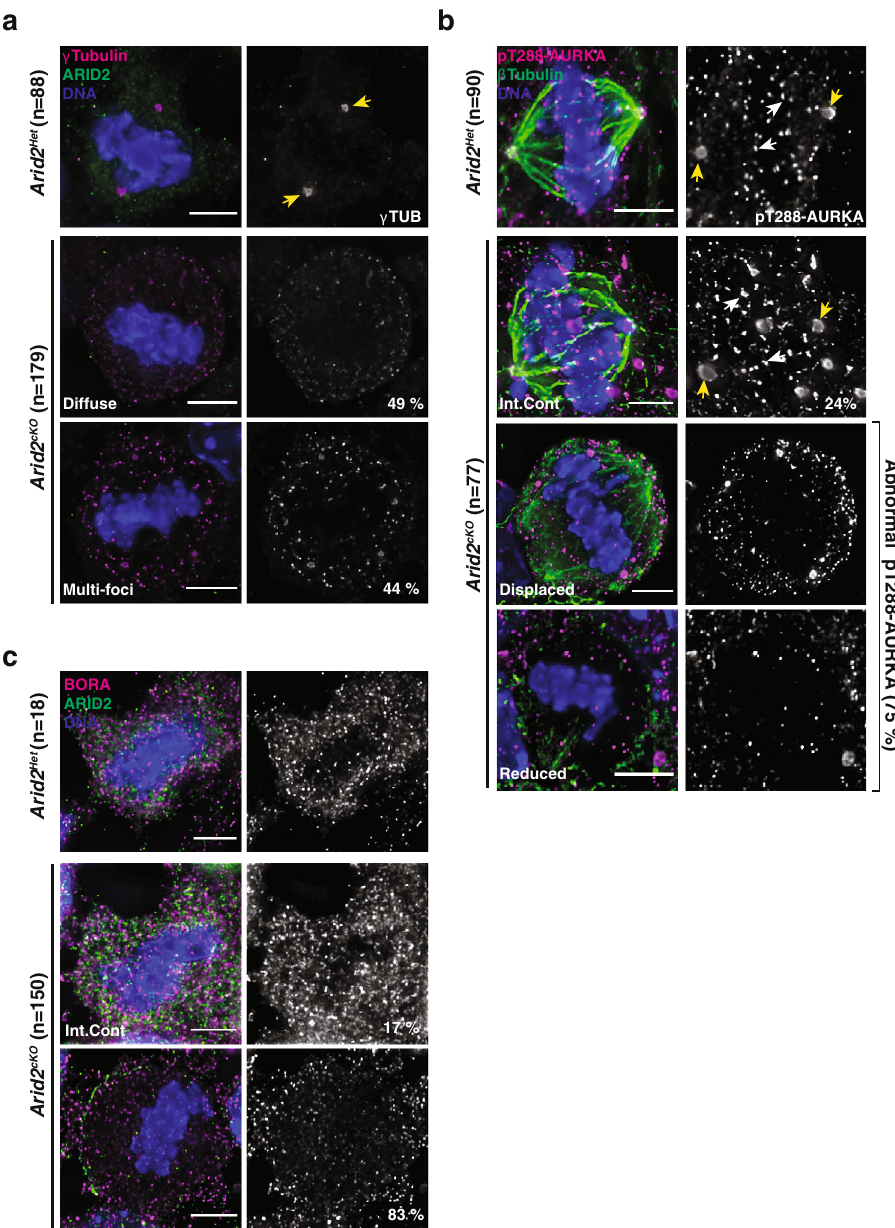
Fig. 5 ARID2 in fl uences the localization of centrosome-associated factors. Arid2 Het and Arid2 cKO metaphase-I spermatocytes immunolabelled for a γ -Tubulin (magenta) and ARID2 (green), b pT288-AURKA (magenta) and β -Tubulin (green), c BORA (magenta) and ARID2 (green), a – c DNA counterstained with DAPI (blue). a , b Centrosomes (yellow arrowheads) and chromosomal loci (white arrowheads) are indicated. Scale bars: 5 μ m, magni fi cation:100.8x. Number ( n ) of metaphase-I spermatocytes scored and proportion (%) of abnormal cells are